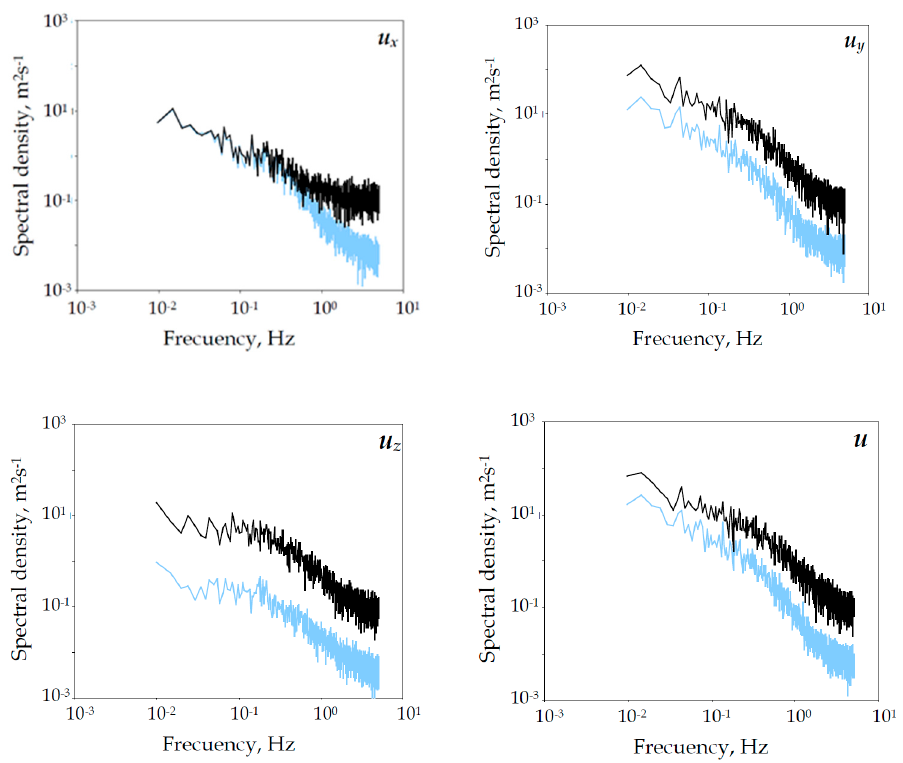
Figure 8. Energy density spectra at outer window side at the north side window (Test 1). Spectra of u x ▬ u y ▬ , and u z (